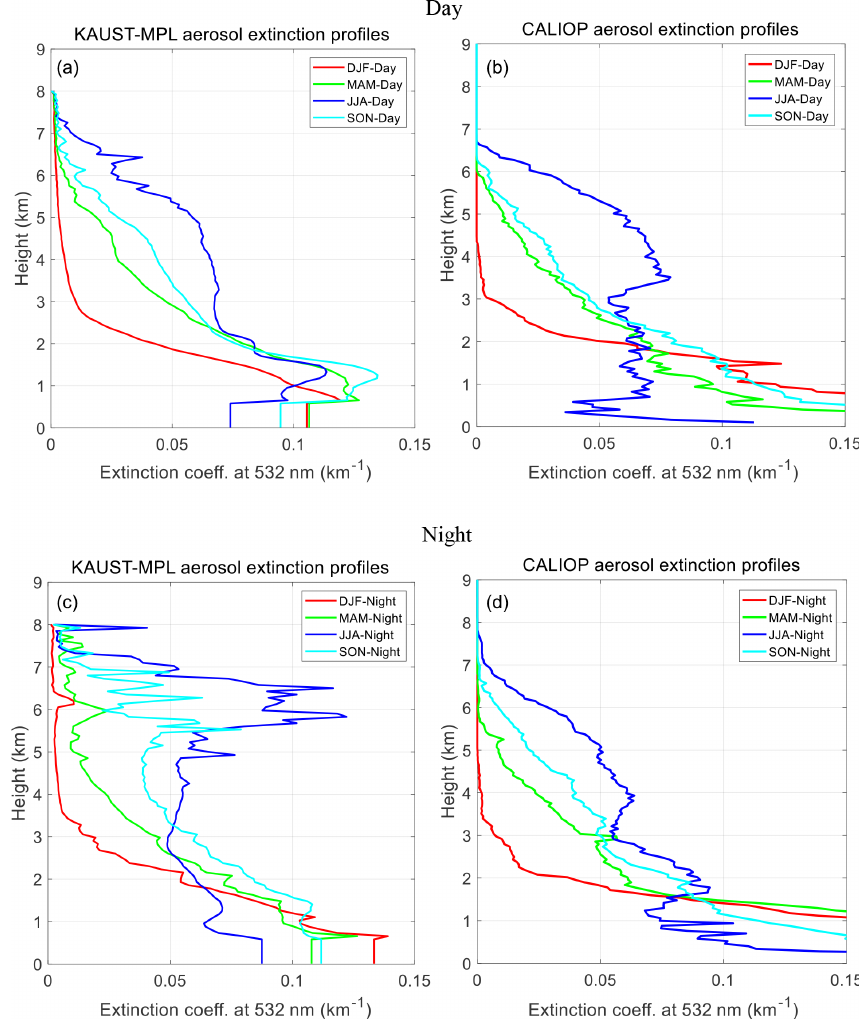
Figure 10. Comparison of seasonal average (2015/16) of aerosol extinction from KAUST–MPL (a, c) and CALIOP (b, d) shown separately for day (a, b) and night (c, d) . Heights are above sea level